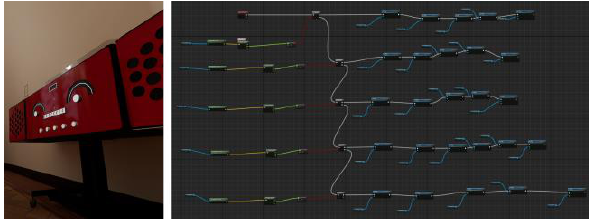
blu dipinto di blu, Yellow submarine, Somewhere over the rainbow, Sing sing sing) (Fig. 10) and the movable tv, which allows you to watch the documentary "Achille Castiglioni: tutto con un niente".